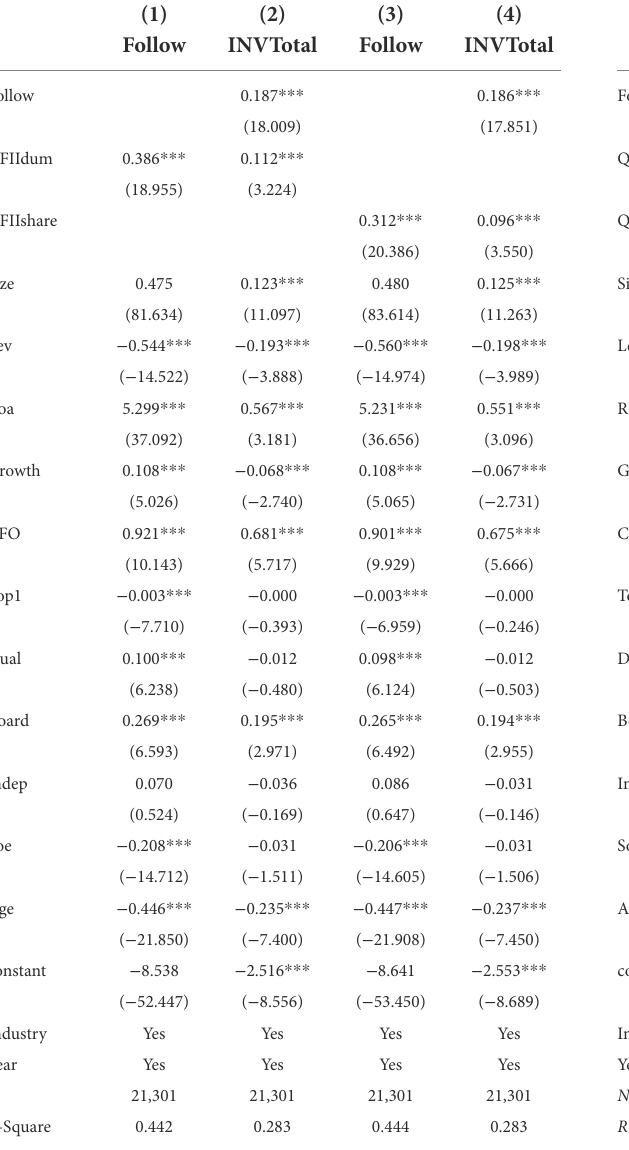
TABLE 6B The impact of QFII on innovation quality: a mechanism test based on analysts following